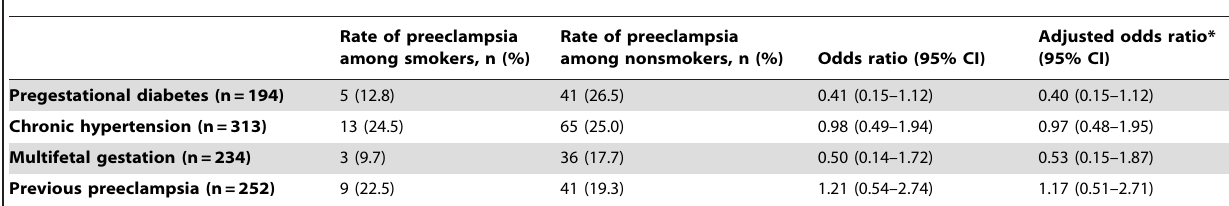
Table 6. Association of smoking and development of preeclampsia in high risk groups.